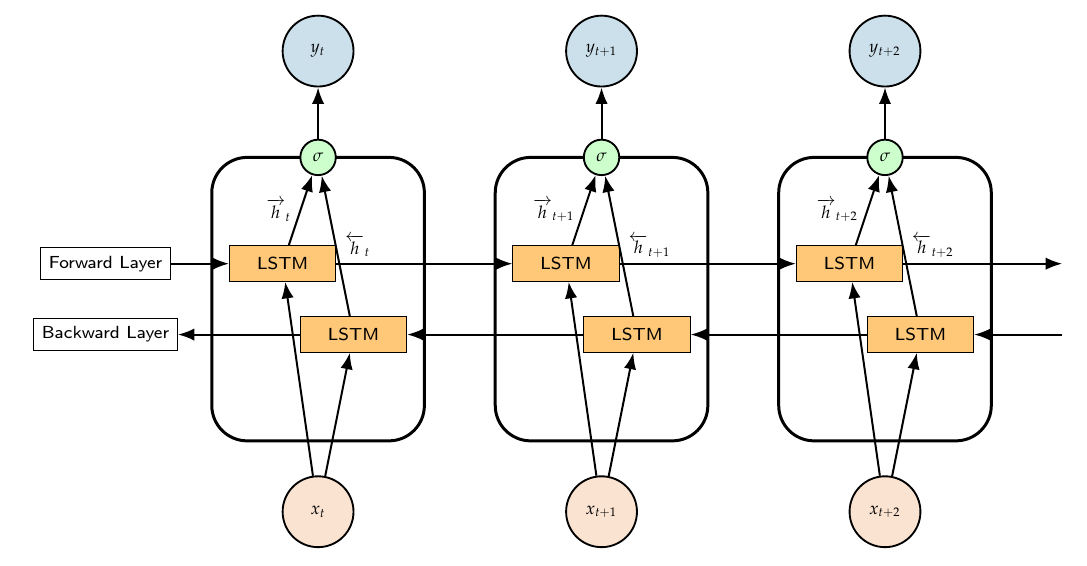
Figure 4. Bidirectional LSTM network